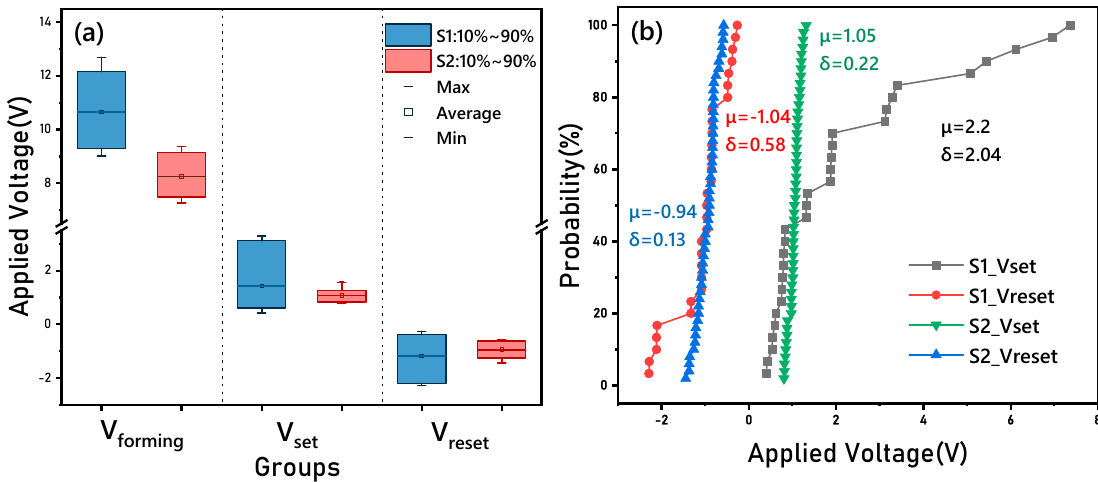
Figure 6. ( a ) Operating voltage distribution of RRAM devices; ( b ) Cumulative probability of SET/RESET voltages.